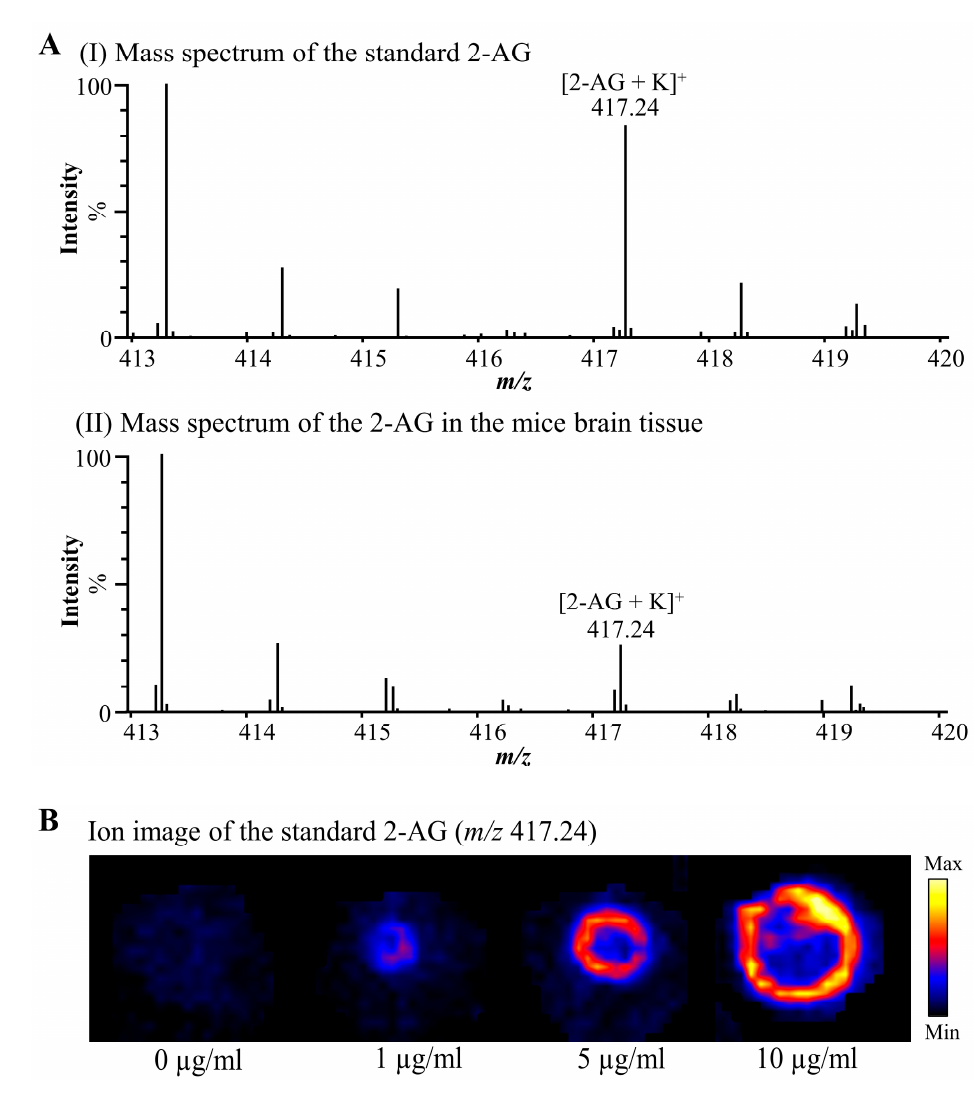
Figure 1. 2-AG was detected from standard 2-AG and male mice brain tissue by DESI-MSI in positive ion mode. ( A ) DESI-MSI mass spectra acquired from (I) standard 2-AG applied to mice brain sections and (II) male mice brain tissues. ( B ) DESI-MSI ion image of different concentrations of standard 2-AG applied to mice brain sections. The concentrations from left to right are 0 µg/mL, 1 µg/mL, 5 µg/mL, and 10 µg/mL. 2-AG: 2-arachidonoylglycerol. Table 1. m/z accuracy of targeted molecules from standard 2-AG and mice brain tissues. Mass Accuracy Assigned Molecule Theoretical m/z Observed m/z